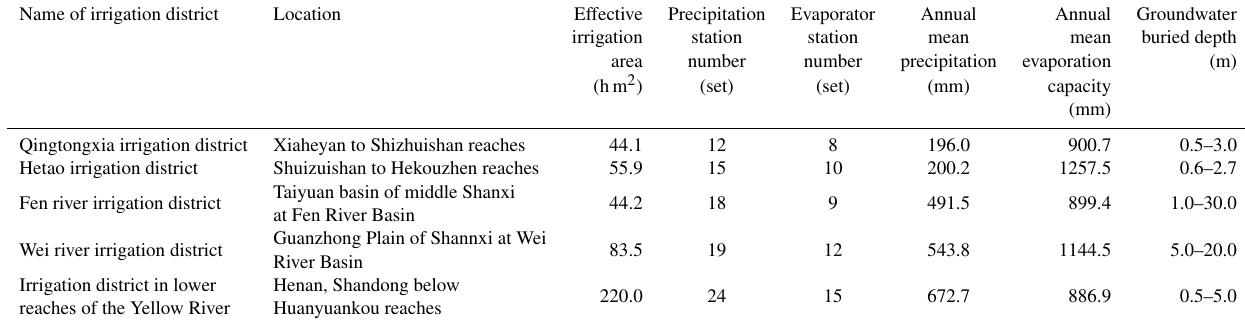
Table 1. Main irrigation districts and there characteristics index in the Yellow River basin. Name of irrigation